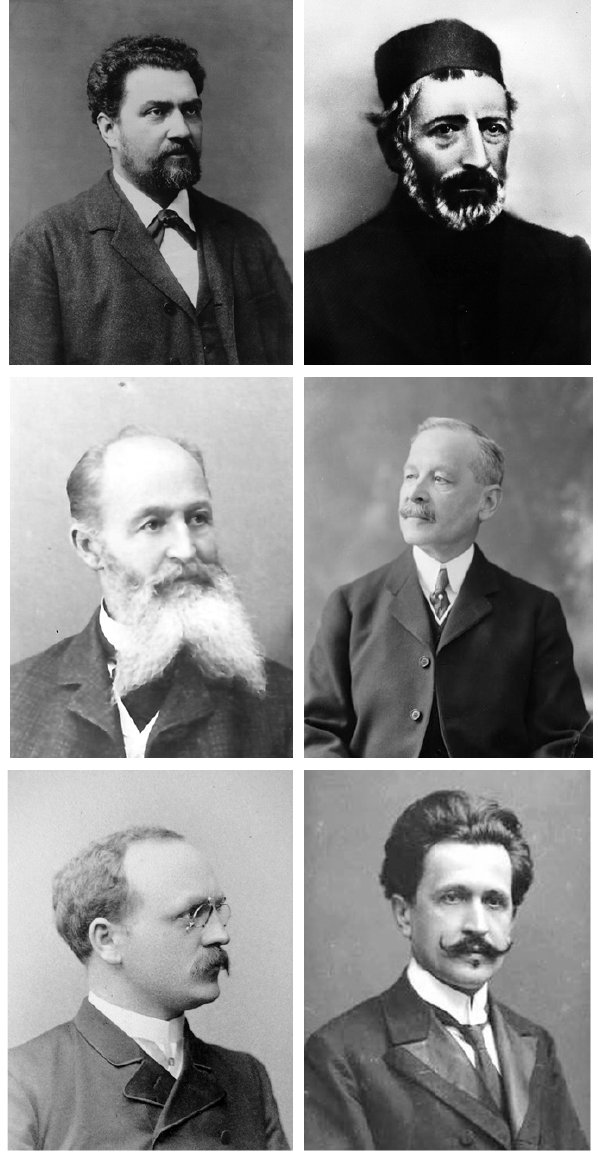
Figure 3. Seed of the international photogrammetric community: from left to right and from top to bottom, A. Meydenbauer (1834-1921), I. Porro (1801-1875), R. Thiele, G.-E. Deville (1849-1924), C. Pulfrich (1858-1927), E. Dolezal